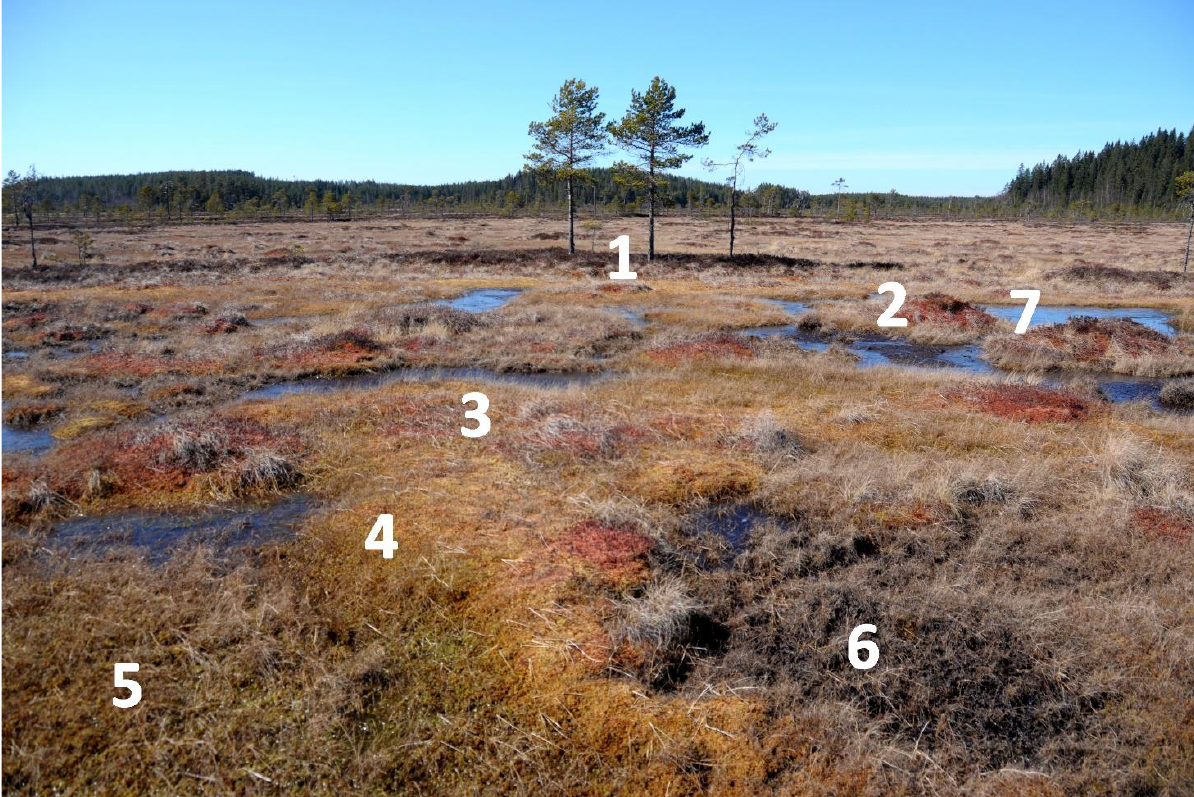
Figure 1. A close-range view of the study area with outlined vegetation classes: 1 = high hummock (HHU) ridge with 1 − 6-m high pine trees; 2 = hummock (HU); 3 = high lawn (HL) with reddish Sphagnum rubellum ; 4 = lawn (L); 5 = hollow (HO); 6 = mud-bottom hollow (MB) with Rhynchospora alba ; 7 = water (W). Cottongrass (CG) tussocks are pale-greyish in